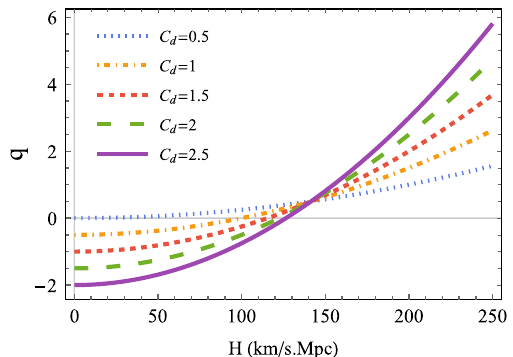
Fig. 5 Deceleration parameter q versus redshift z for three different valuesof d − Δ , C d = 1 . 5,and D d ,Δ = − 0 . 005.Noticethebigchanges in q for small variations in d −